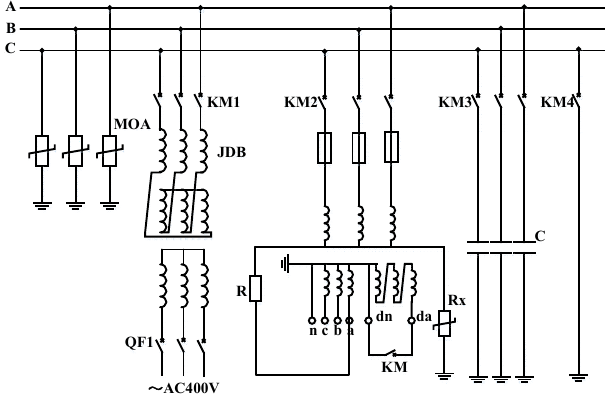
Figure 13. Test schematic.